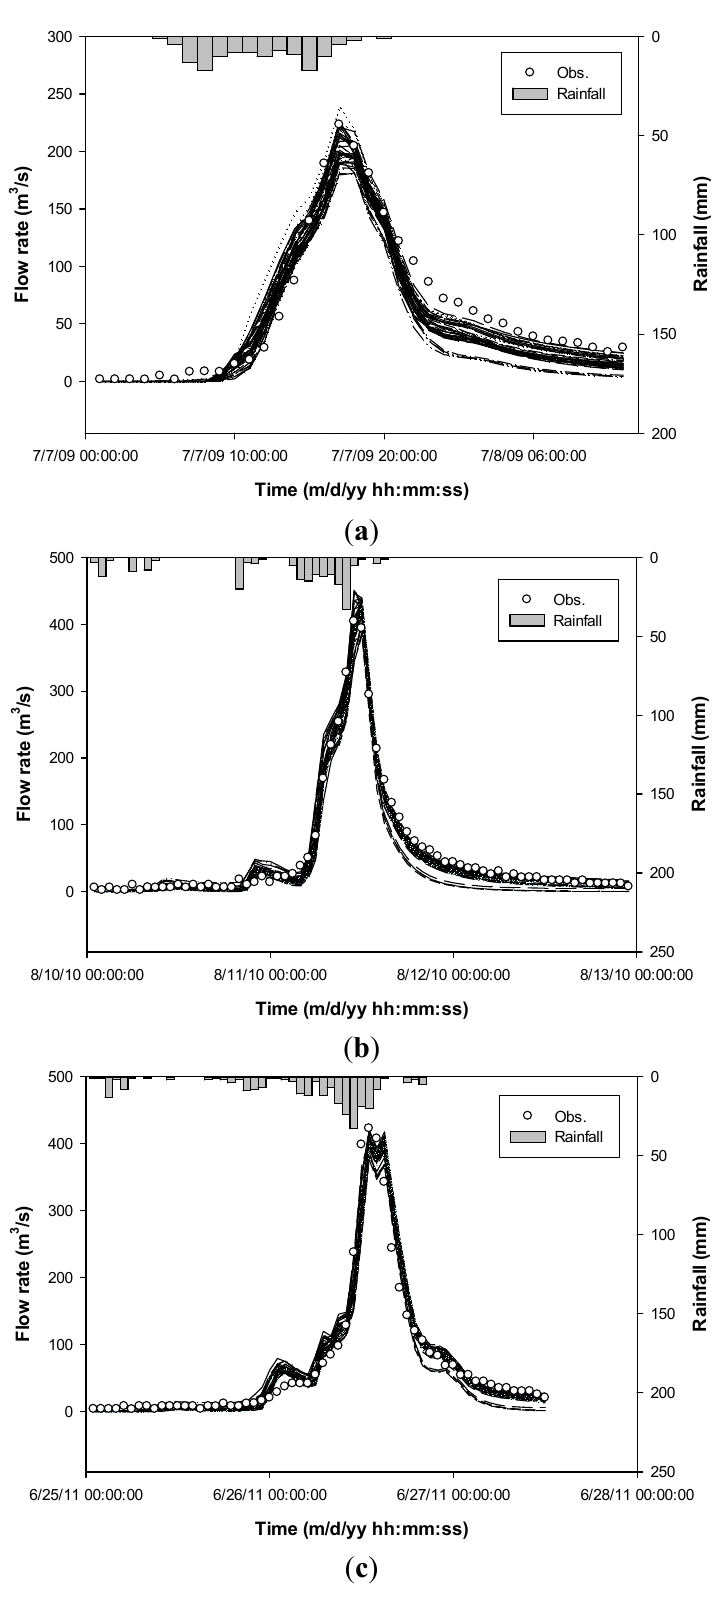
Figure 5. Simulated hydrographs of E3, E4, and E5 with 41 calibrated parameter sets. ( a ) E3 (20090707); ( b ) E4 (20100810); ( c ) E5